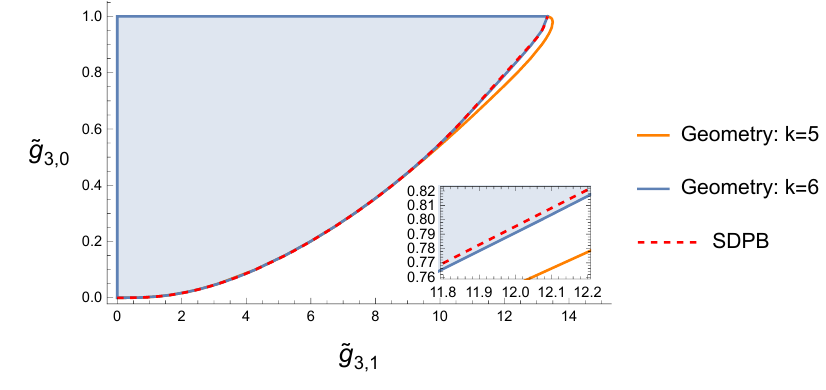
Figure 5 . Geometry bound and SDPB bound for (˜ g 3 , 1 , ˜ g 3 , 0 ) space. Including higher order couplings and constraints improves the geometry bound. The region with the maximal mismatch is zoomed in for